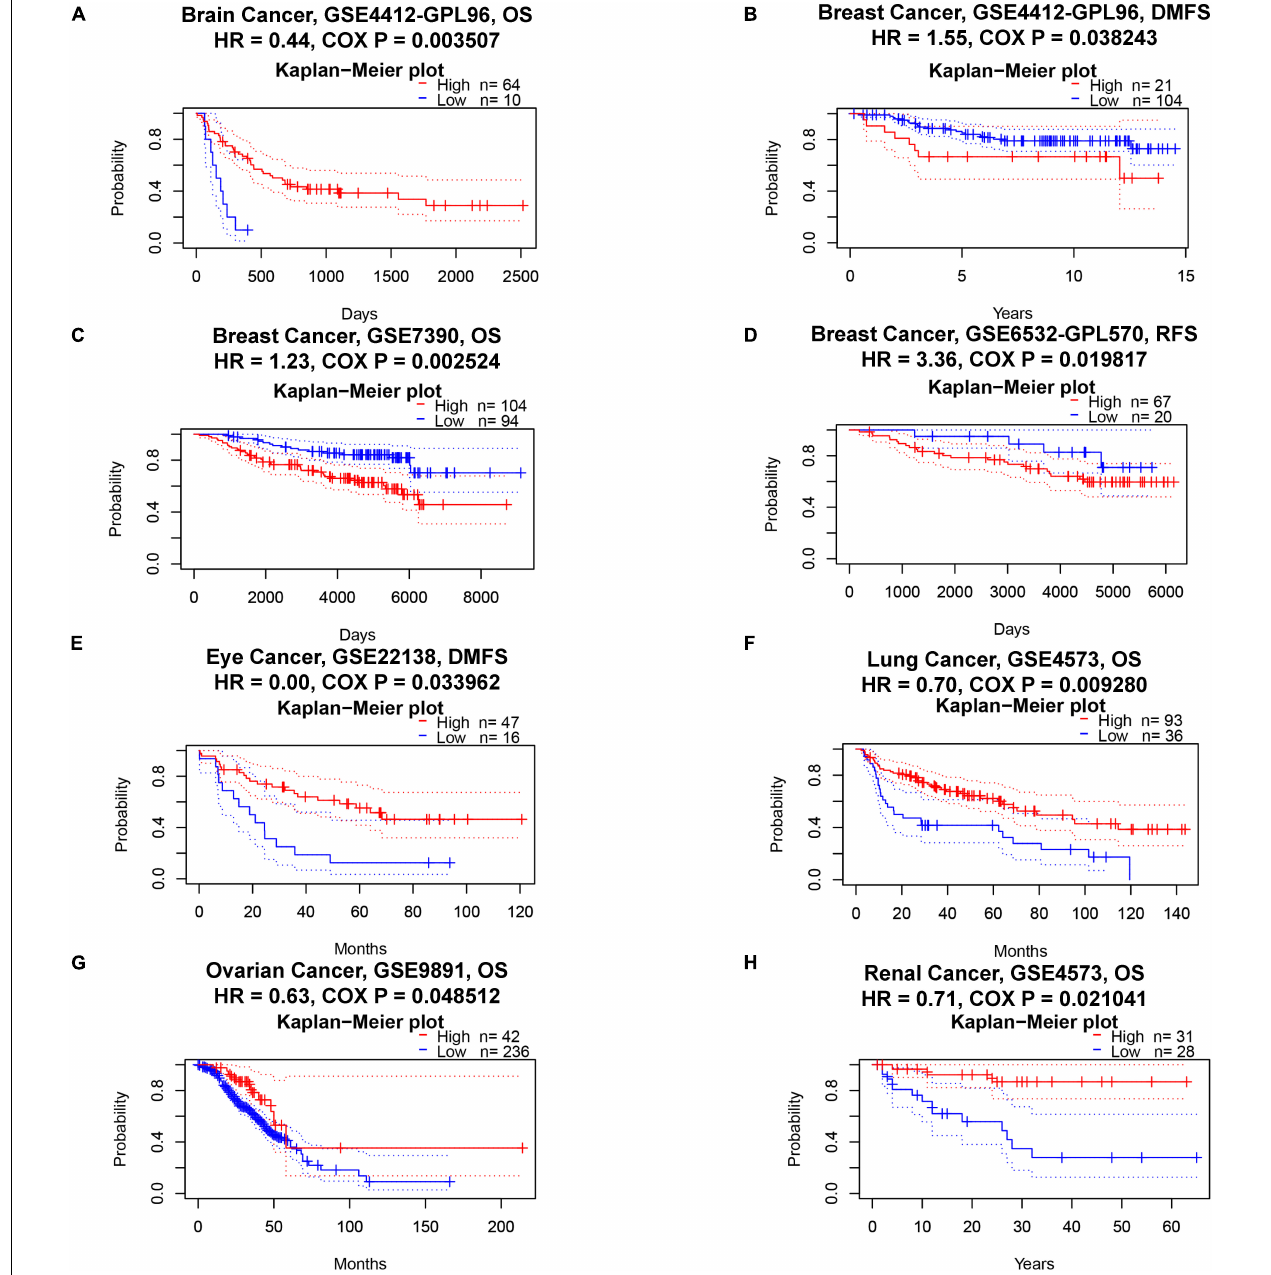
FIGURE 2 | Kaplan–Meier survival curves comparing high and low expression of ACE2 in different cancer types in PrognoScan. OS, overall survival; DMFS, distant metastasis-free survival; RFS, relapse-free survival. (A) OS of Brain Cancer. (B–D) DMFS, OS and RFS of Breast Cancer. (E) DMFS of Eye Cancer. (F) OS of Lung Cancer. (G) OS of Ovarian Cancer. (H) OS of Renal